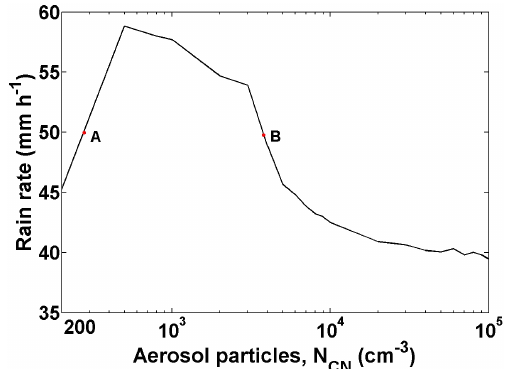
Figure 1. Conceptual model of the nonlinear relationship between aerosol concentrations and rain rate (data are from 2-D simulation results of this